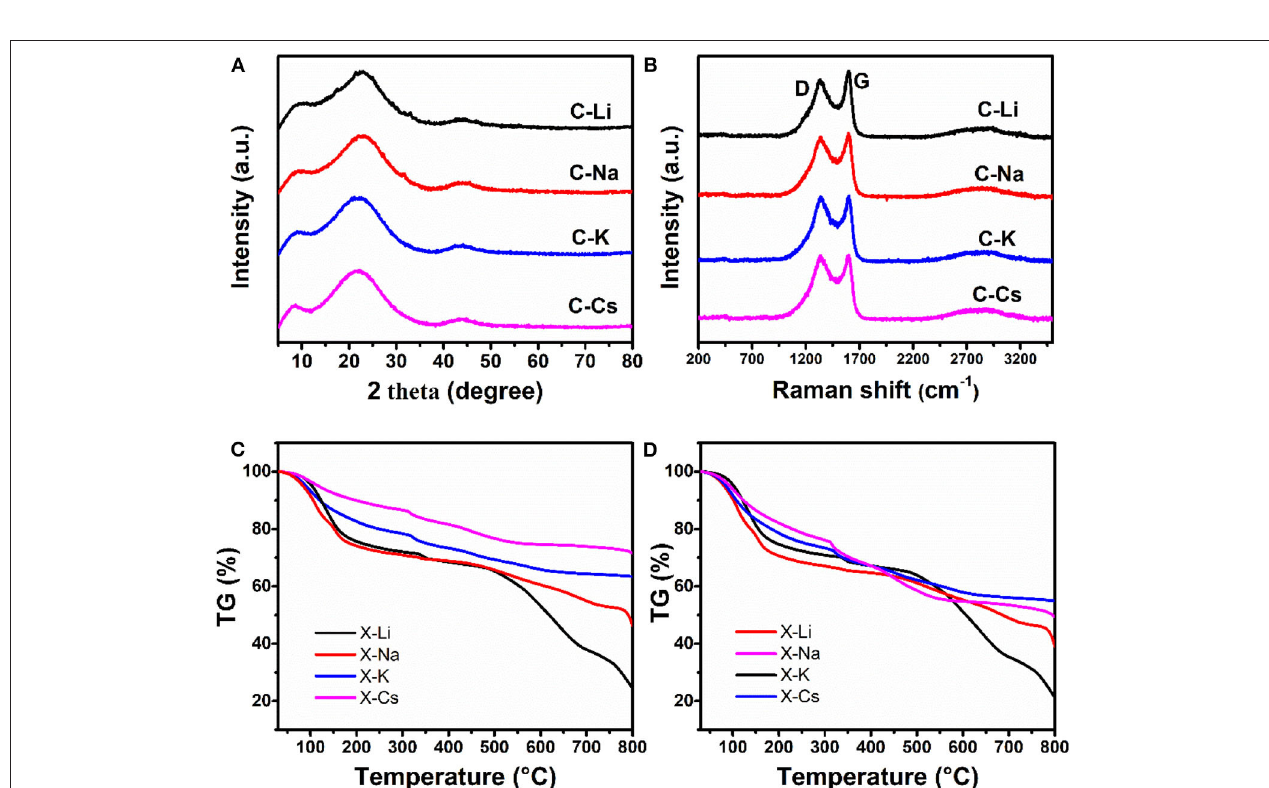
FIGURE 2 | X-ray diffraction patterns (A) , Raman spectra (B) for C-Ms, TGA for X-Ms (C) , normalized TG curves derived from c as each X-M subtract the corresponding metal content (D) .